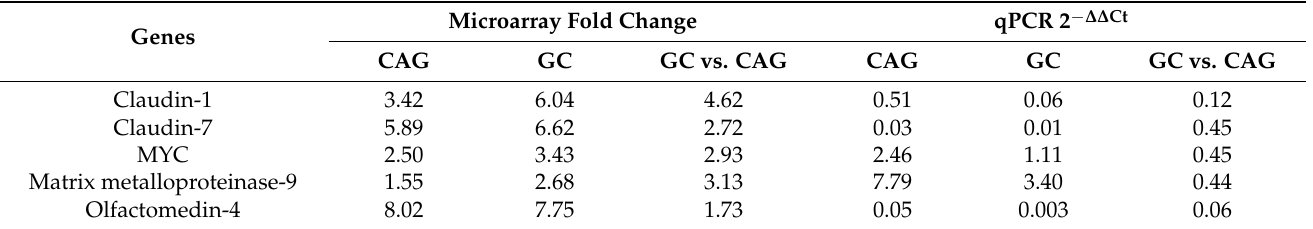
Table 5. Quantitative PCR confirmation of selected genes.